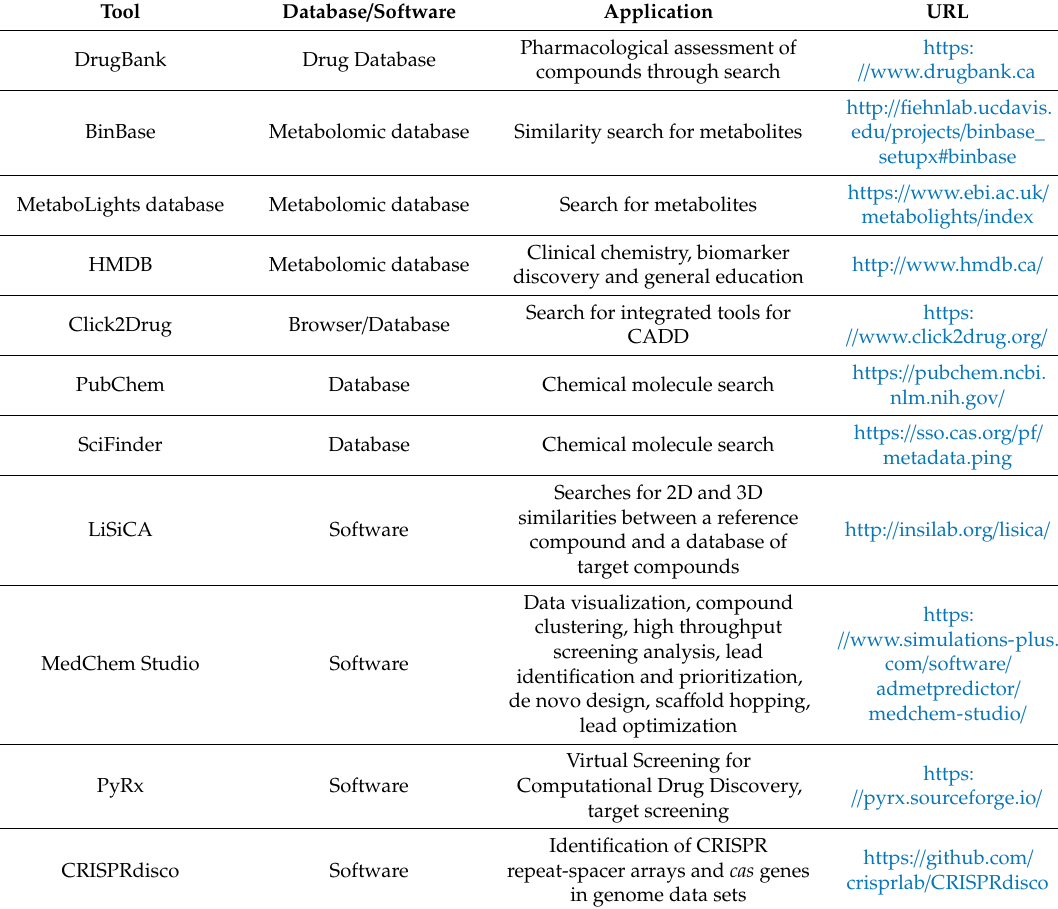
Table 4. Databases and software tools for virtual screening of drug